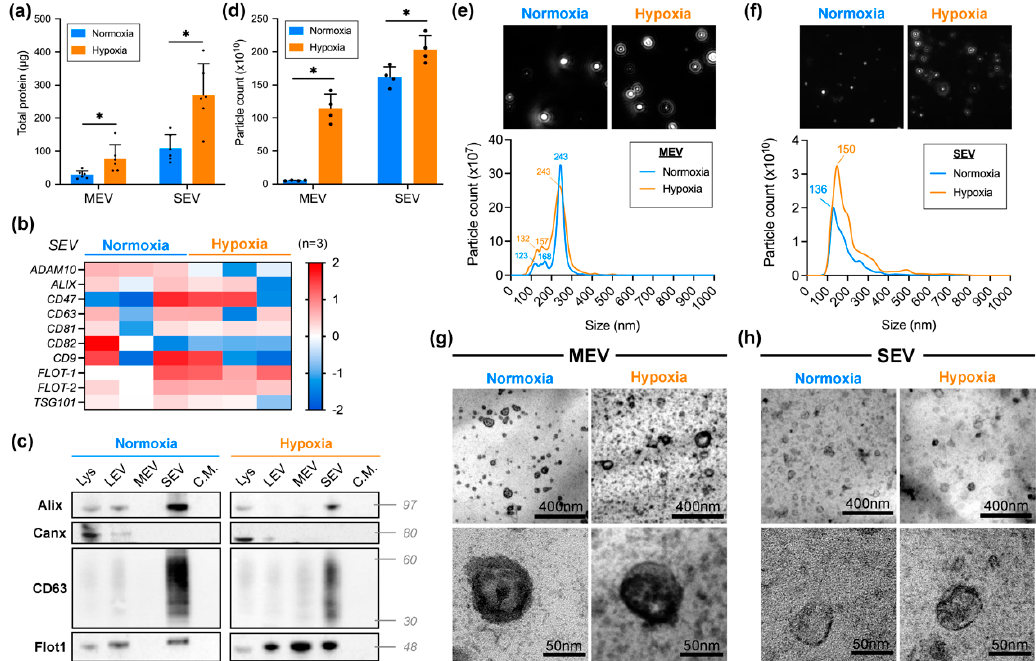
Figure 1. Isolation and characterization of EVs. ( a ) Total protein content for normoxic ( blue ) and hypoxic ( orange ) MEV and SEV. Data presented as mean ± SD (standard deviation). ( b ) SEV bi- omarker profile obtained via proteomic analysis. Each column indicates a biological replicate ( n = 3). ( c ) Immunoblotting membranes probed for proteins Alix, calnexin (Canx), CD63, and flotillin-1 (Flot1) containing samples of cell lysate (Lys), LEV, MEV, SEV, and the leftover conditioned media (C.M.) of EV isolations. ( d ) Particle count for MEV and SEV (mean ± SD). ( e , f ) Mean vesicle size dispersion for ( e ) MEV and ( f ) SEV ( n = 5). ( g , h ) Transmission electron microscopy images of broad field and individual ( g ) MEV and ( h ) SEV. Scale bar: 400 nm ( top ), 50 nm ( bottom ) * p < 0.05.